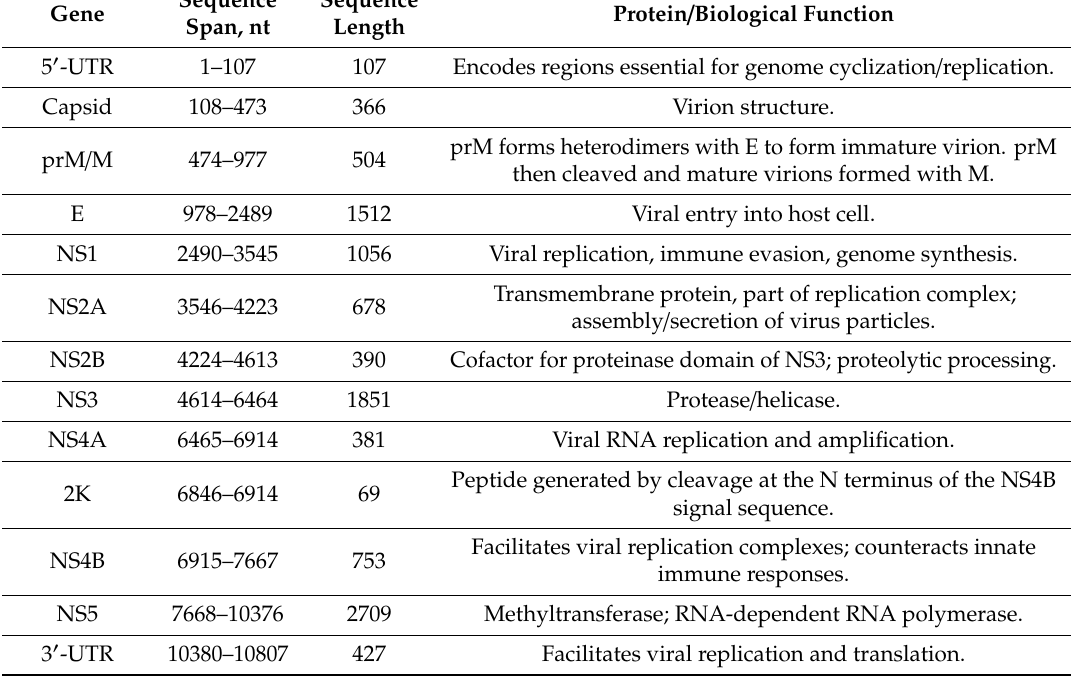
Table 1. Structure of a typical flavivirus genome including UTRs. Typical sequence length data taken from ZIKV isolate ZIKV / H. sapiens / Brazil / PE243 / 2015 (GenBank Locus ID KX197192),